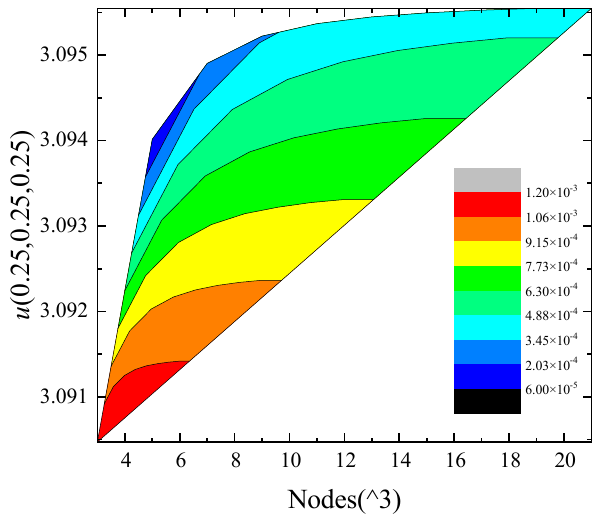
Figure 3. The contour plot of nodes, numerical solutions, and the relative errors.